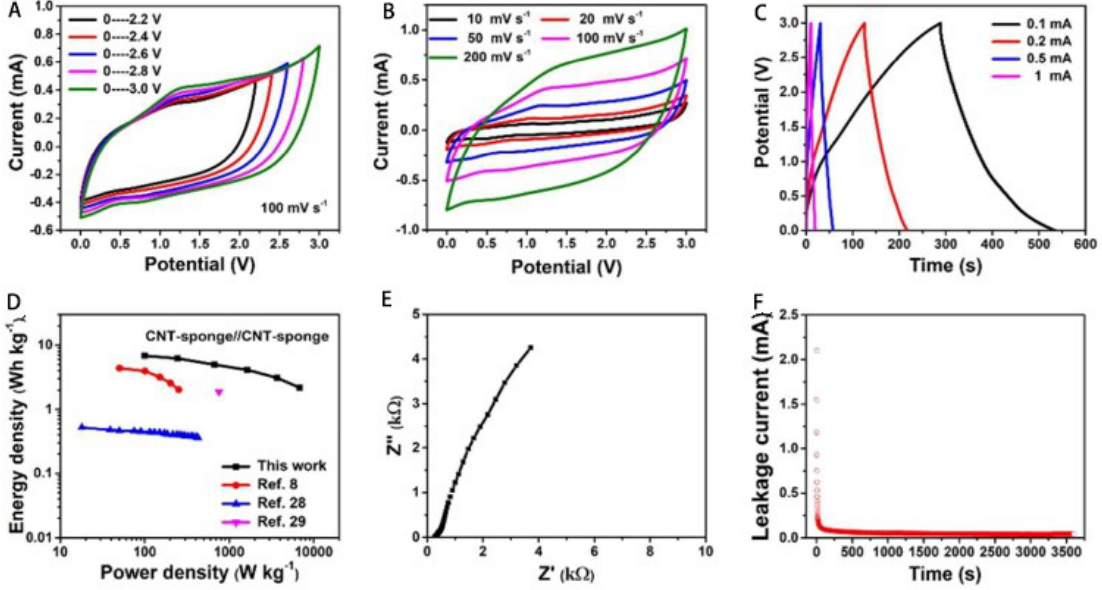
Figure 2: Electrochemical performances of the CNT-aerogel//CNT-aerogel FSC device. (A) CV curves measured in different potential window at 100 mV · s −1 . (B) CV curves in the voltage window of 0-3 V at a scan rate range of 10 to 200 mV · s −1 . (C) GCD curves at different current densities in the same voltage window of 0-3 V. (D) Ragone plots comparing the energy density and power density with previously reported studies. (E) Nyquist plot in the frequency range of 100 kHz to 10 mHz. (F) Leakage current curves of the FSC device charged to